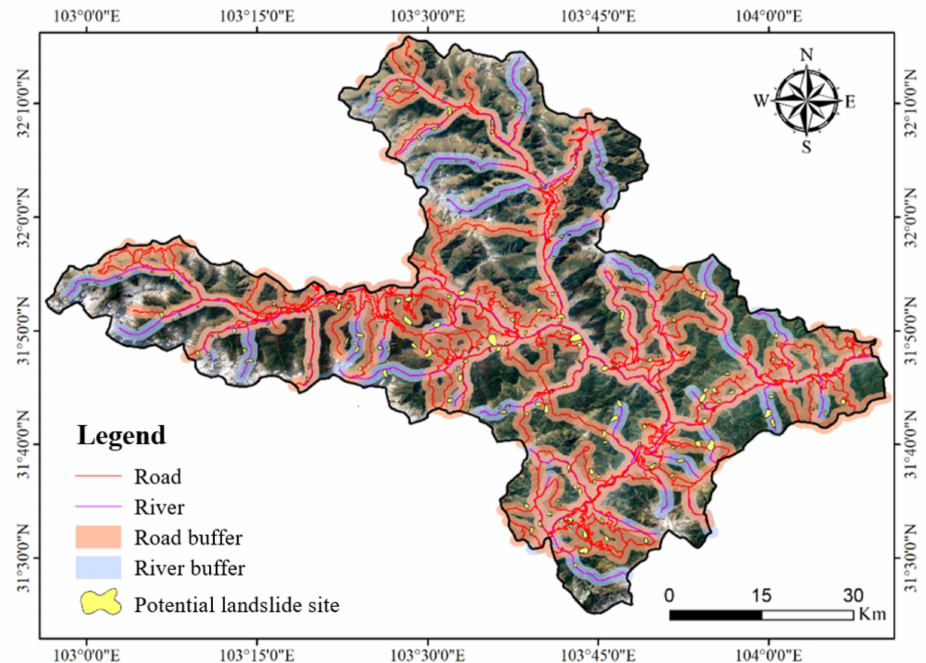
Figure 26. Extraction of potential landslide site in the study